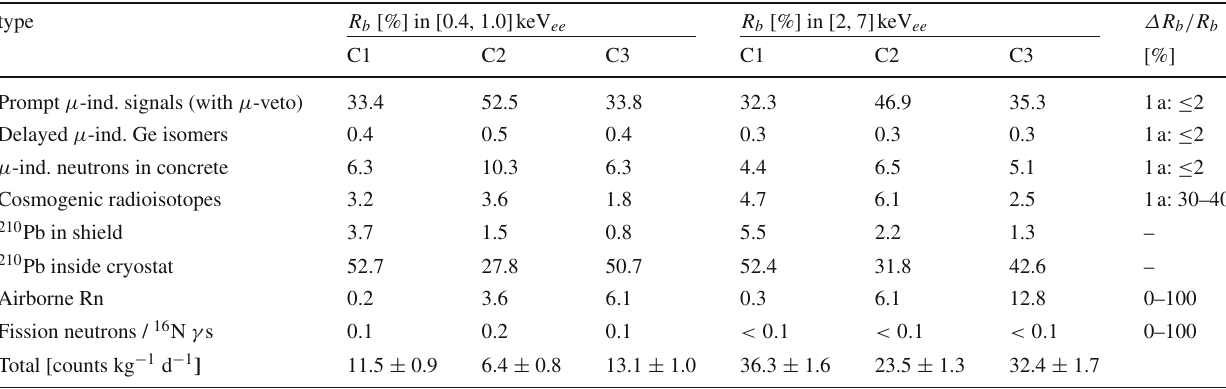
Table 13 Relative contributions R b (unit: %) from different background sources to the measured total background rates, as determined for the C1–C3 detectors at the beginning of Run -1. Typical relative rate changes are reported in the last column